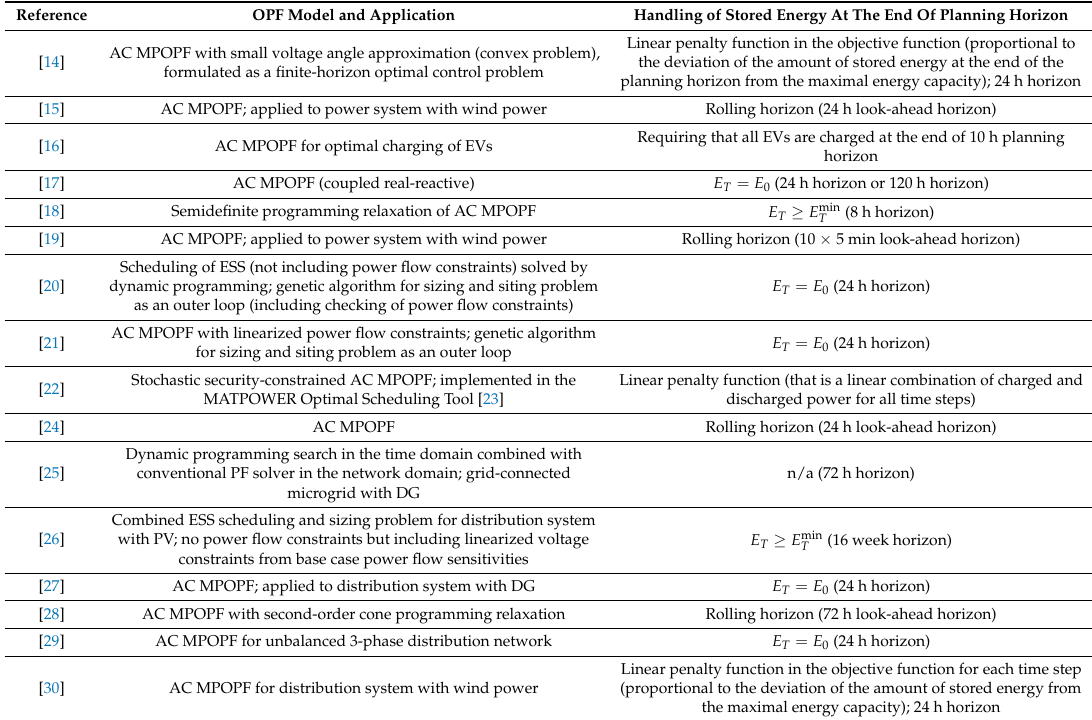
Table 1. Overview of literature on AC multi-period optimal power flow